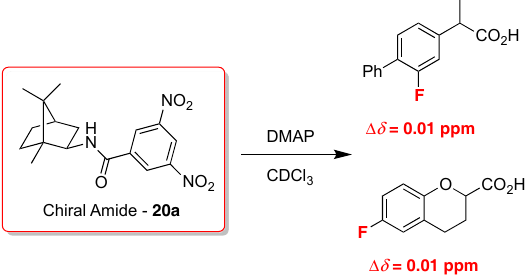
Scheme 16. Synthesis of isobornyl derived amides as CSA for enantiodiscrimination of binaphthyl by 31 P { 1 H} NMR spectroscopy. Molecules 2017 , 22 , 31